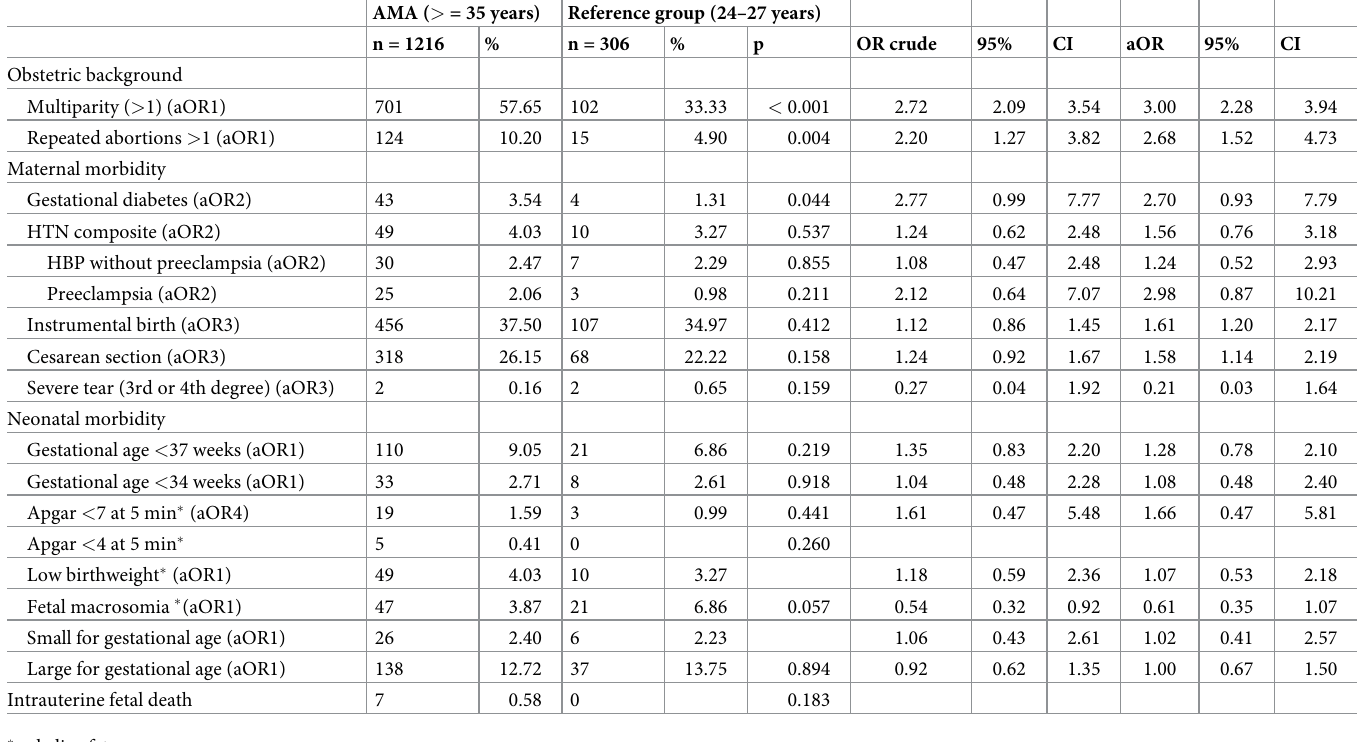
Table 2. Associations between AMA and obstetric background, maternal and neonatal morbidity, and intrauterine fetal